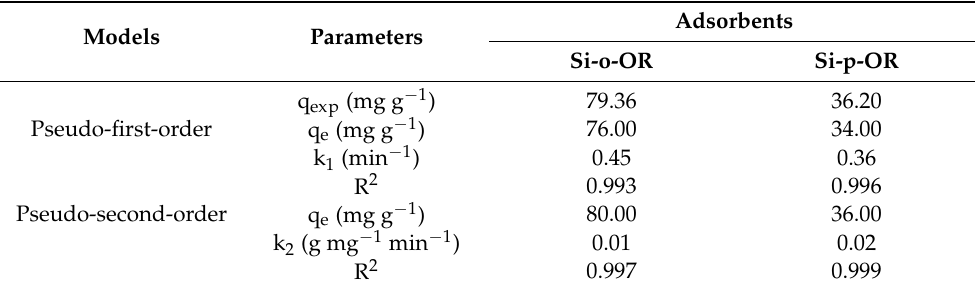
Table 1. Kinetics model data of Cu(II) adsorption.